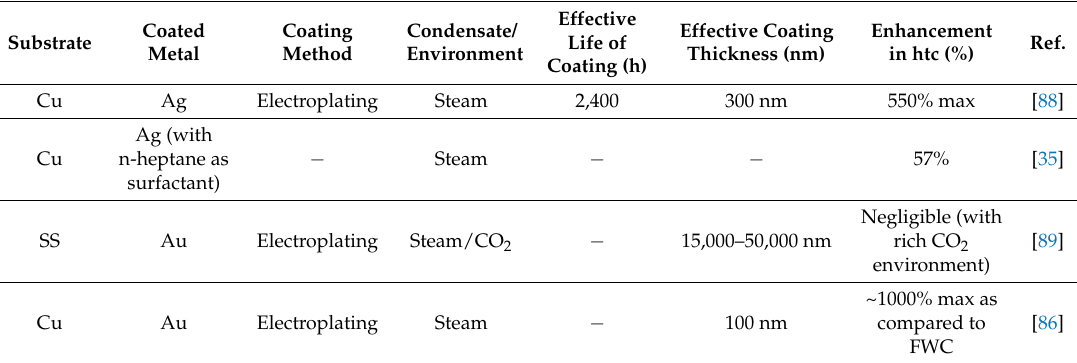
Table 1. Condensation enhancements by noble metal coatings.